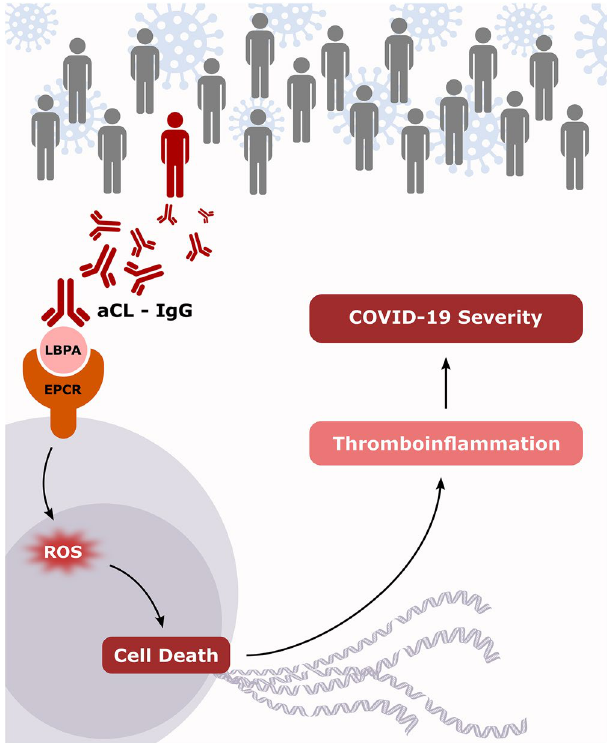
Figure 4. Putative mechanism of anticardiolipin autoantibodies in COVID-19 severity. We hypothesize that SARS-CoV-2 infection of genetically-prone patients results in autoimmunity. Anticardiolipin autoantibodies (aCL) can bind a cell surface complex composed of lysobiphosphatidic acid (LBPA) and endothelial protein C receptor (EPCR). This interaction promotes cell death via reactive oxygen species (ROS). Then, releases extracellular DNA contributes to a heightened thrombo-inflammatory state associated with COVID-19 severity. The figure has been drawn by AB using InkScape 0.92, http:// www. inksc ape.